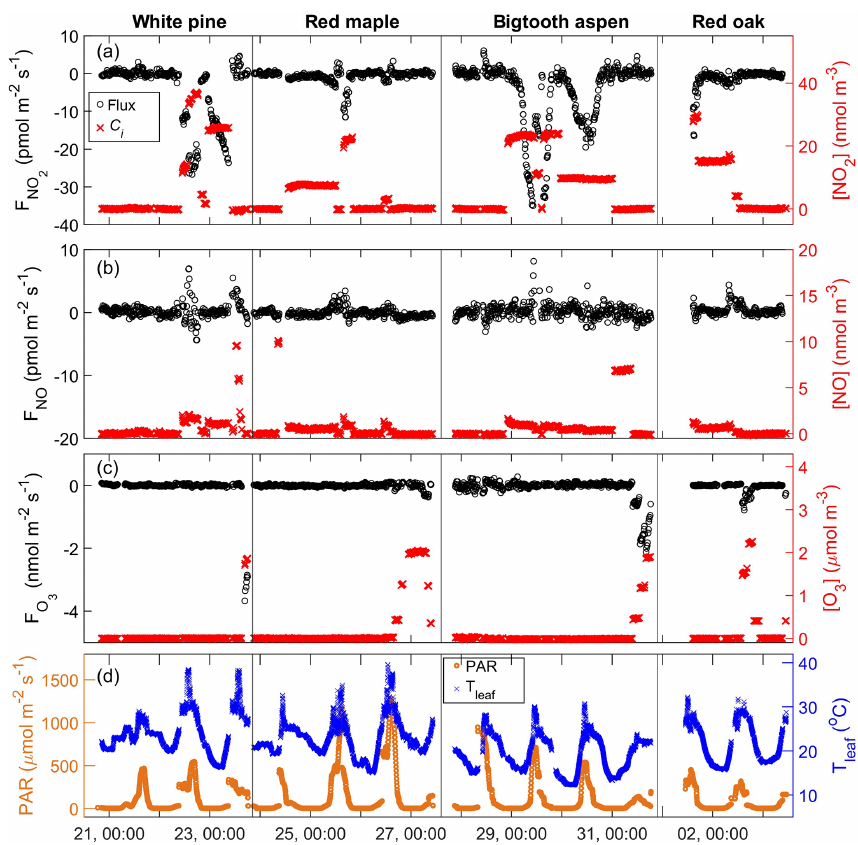
Figure 4. Time series of the enclosure gas exchange experiments from 21 July to 3 August, showing the trace gas fluxes (black symbols: o, left axis) and input trace gas concentrations, c i (red symbols: x, right axis), of (a) NO 2 , (b) NO, and (c) O 3 . Solar irradiation PAR (orange: o, left axis) and temperature of the enclosure leaves (blue: x, right axis) are shown in the bottom panel (d) . The tree species are labeled for each enclosure period at the top of the figure. The x -axis tick label format is day,